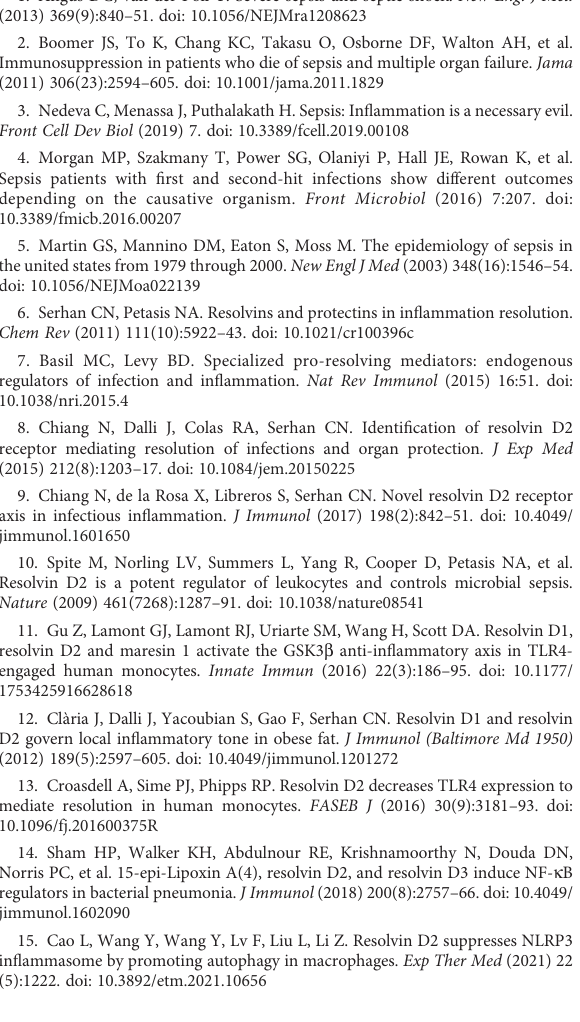
SUPPLEMENTARY FIGURE 2 Liver Tissue cytokine levels. Sham or CLP surgery wasperformed on mice. CLP mice were given vehicle saline or RvD2 48h after surgery. Mice were sacri fi ced 24h later and liver samples were taken and homogenized in 2mL of T-PER buffer containing protease inhibitors and homogenized according to our protocol (17). Cytokines of liver extracts were measured by ELISA (Thermo fi sher Scienti fi c). Liver IL-6 levels were not changed between the 3 groups. Macrophage in fl ammatory protein-2 (MIP2) levels were increased in livers of CLP and CLP + RvD2 mice compared to sham controls. Similarly, Liver Il-10 levels were increased in CLP and CLP + RvD2 mice compared to sham controls. * P < 0.05 for n = 3-7 mice in all